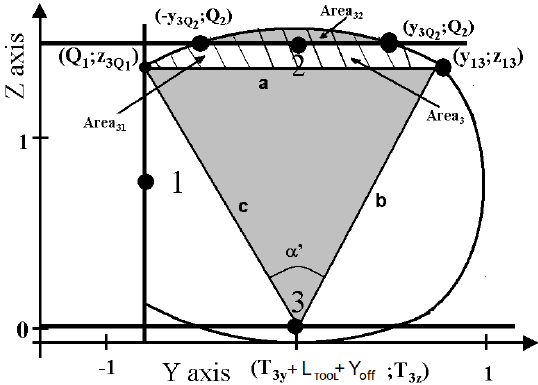
Figure 13: Illustration of workspace Area